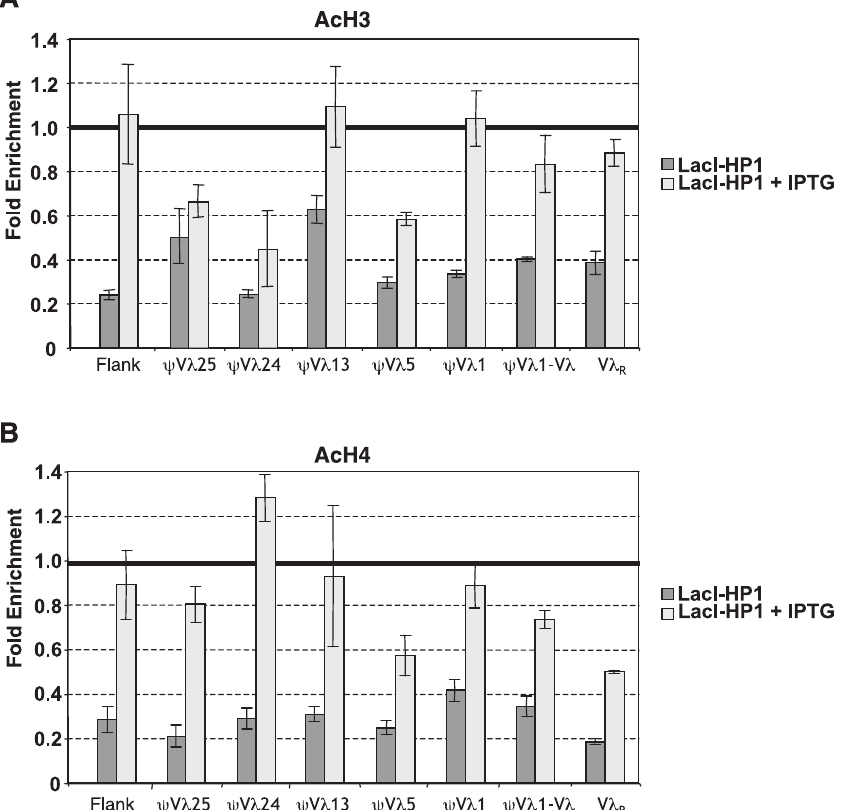
Figure 5. Tethered HP1 Decreases Histone Acetylation throughout the w V k Array (A) Summary of a ChIP experiment, assaying N-terminal acetylation of histone H3 in chromatin from the DT40 PolyLacO-V k R LacI-HP1 cell line cultured for 3 d in the presence or absence of 250 l M IPTG. ChIP enrichment values (see Material and Methods) were normalized to values obtained from a parallel analysis of chromatin from DT40 PolyLacO-V k R GFP-LacI cells. Bars indicate standard deviation of four separate amplifications of increasing amounts of template DNA. (B) Summary of a ChIP experiment, assaying N-terminal acetylation of histone H4 in chromatin from the DT40 PolyLacO-V k R LacI-HP1 cell line cultured for 3 d in the presence or absence of 250 l M IPTG. Details as in